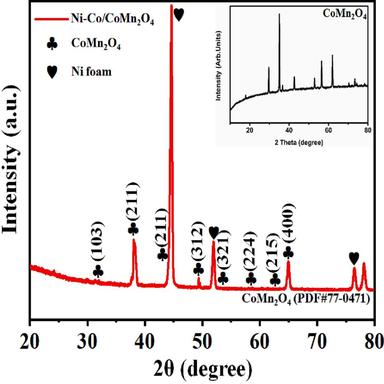
XRD pattern for Ni-Co/CoMn2O4 composite materials grown on Ni form.